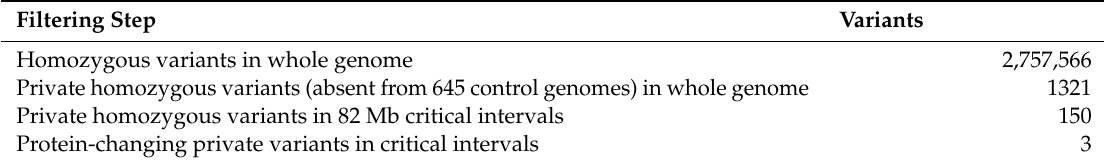
Figure 2. Pedigree of the three investigated cases. Filled symbols represent puppies deceased by the age of six to eight weeks. Open symbols represent una ff ected animals. Genotypes at YARS2 :c1054G > A are indicated for all dogs, from which a DNA sample was available. The grey rectangle indicates the five dogs included in linkage and homozygosity analysis. Table 1. Variants detected by whole genome re-sequencing of an a ff ected puppy.